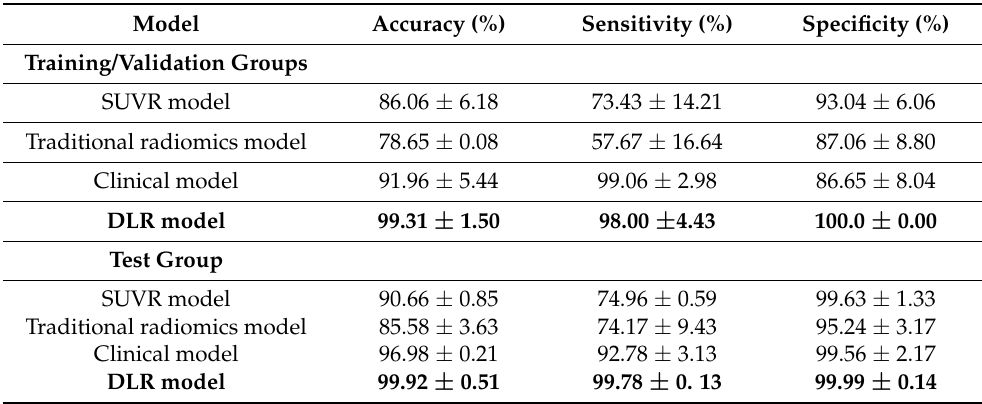
Table 7. The classification performance in NC vs.